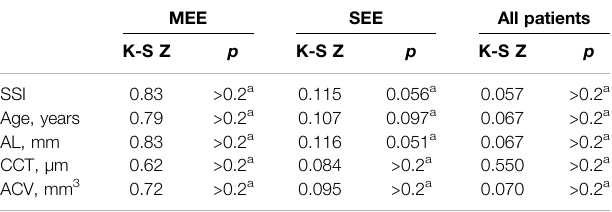
TABLE 1 | Kolmogorov-Smirnov test of parameters.